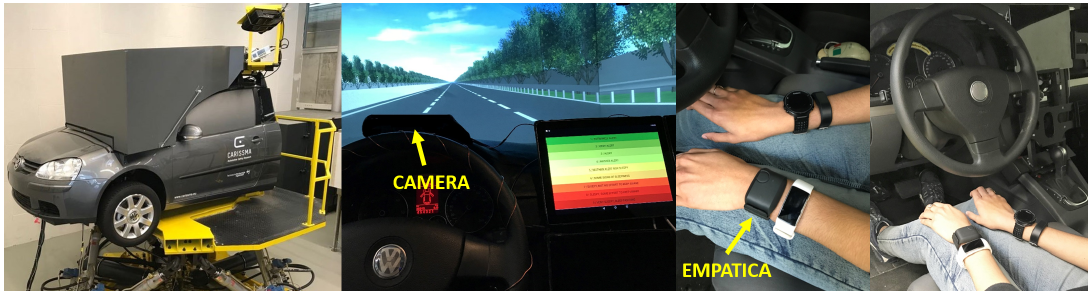
Figure 2. ( Left ) High-fidelity driving simulator (Hexapod system) as used in the study; ( Center ) Study setup with camera mounted on top of cockpit; ( Right ) Wearable devices on wrist of